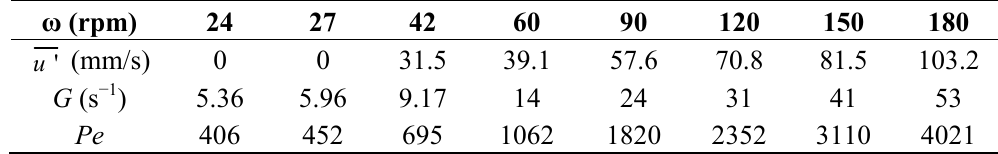
Table 1. Shear flow parameters with respect to different angular velocities of the inner